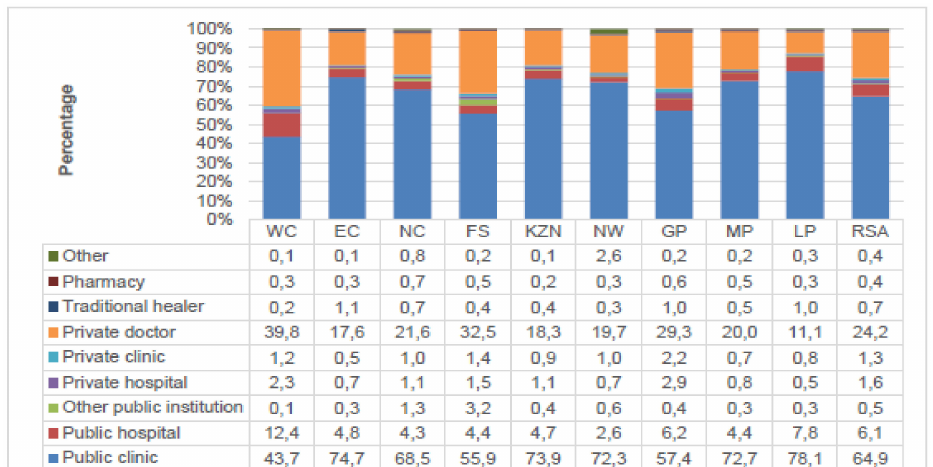
Figure 1. Percentage distribution of the type of healthcare facility consulted first by the households when members fall ill or get injured by province. Source: StatsSA